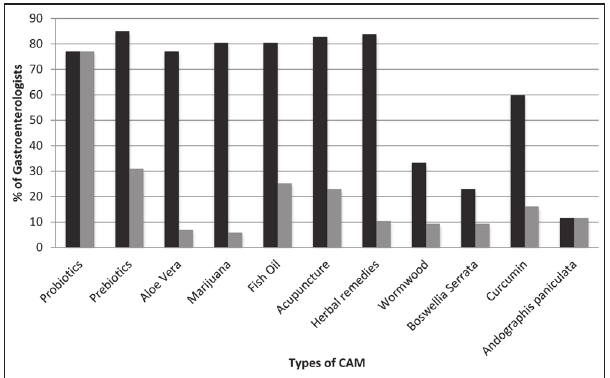
Figure 3) Gastroenterologists’ familiarity with and recommendation practi- ces for specific modalities of complementary alternative medicine (CAM). Black bars represent the proportion of respondents who were familiar with a specific type of CAM and grey bars represent the proportion who recom- mended that specific